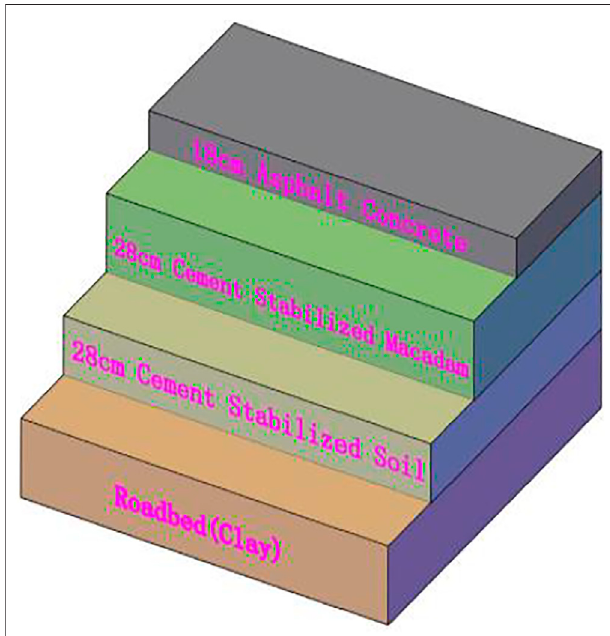
FIGURE 12 | Pavement structure layer combination in the physical engineering inspection